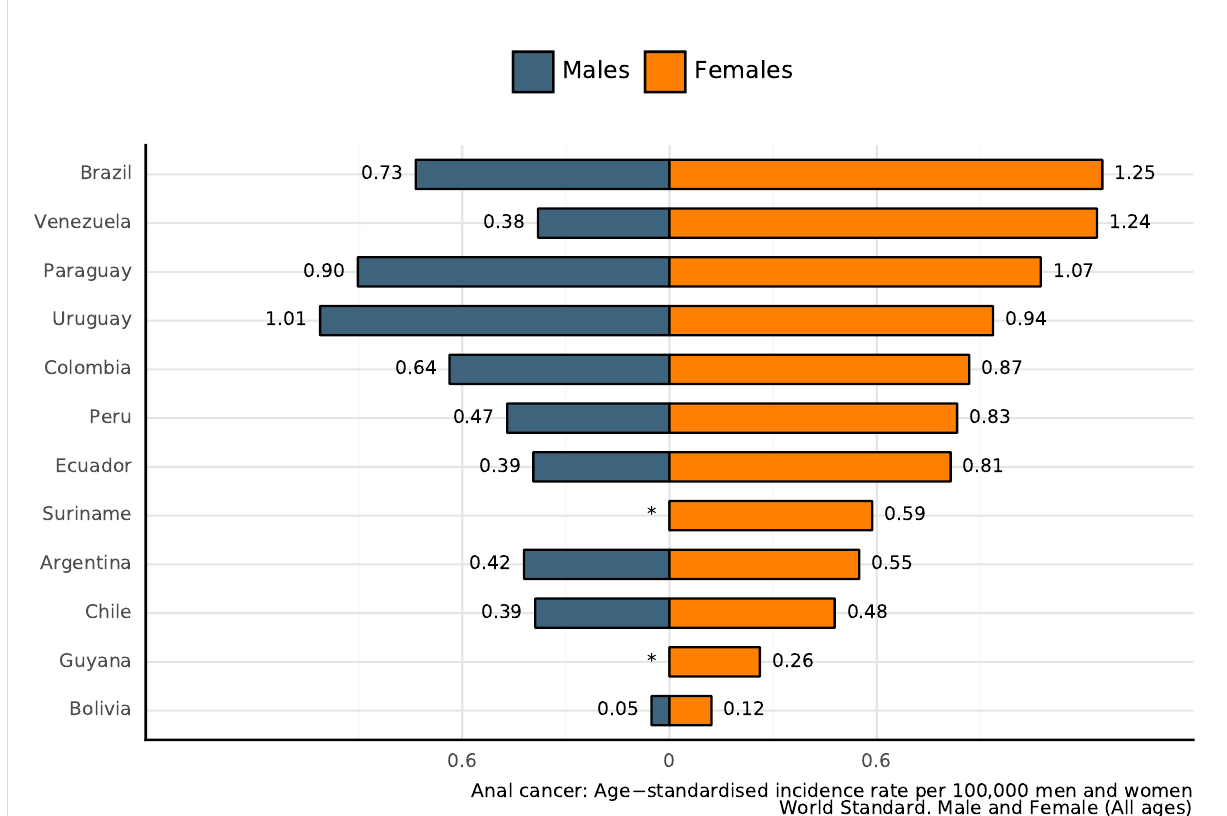
ages)BoliviaGuyanaChileArgentinaSurinameEcuadorPeruColombiaUruguayParaguayVenezuelaBrazil Anal cancer: Age standardised incidence rate per 100,000 men and women World Standard. Male and Female (All